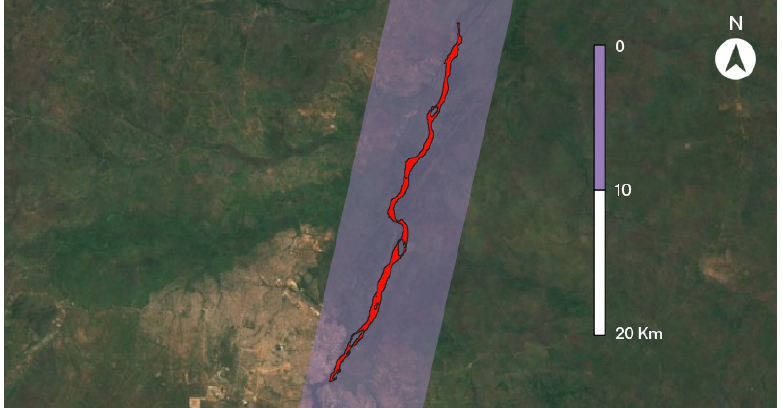
Figure 7. Virtual station (in red) leading to unreliable water level time series. The orientation of the river bed follows the S3 satellite track (in purple) over almost 30 km. For each date, all pulse observations falling into this geometry are averaged introducing artifacts due to great variations occuring along the